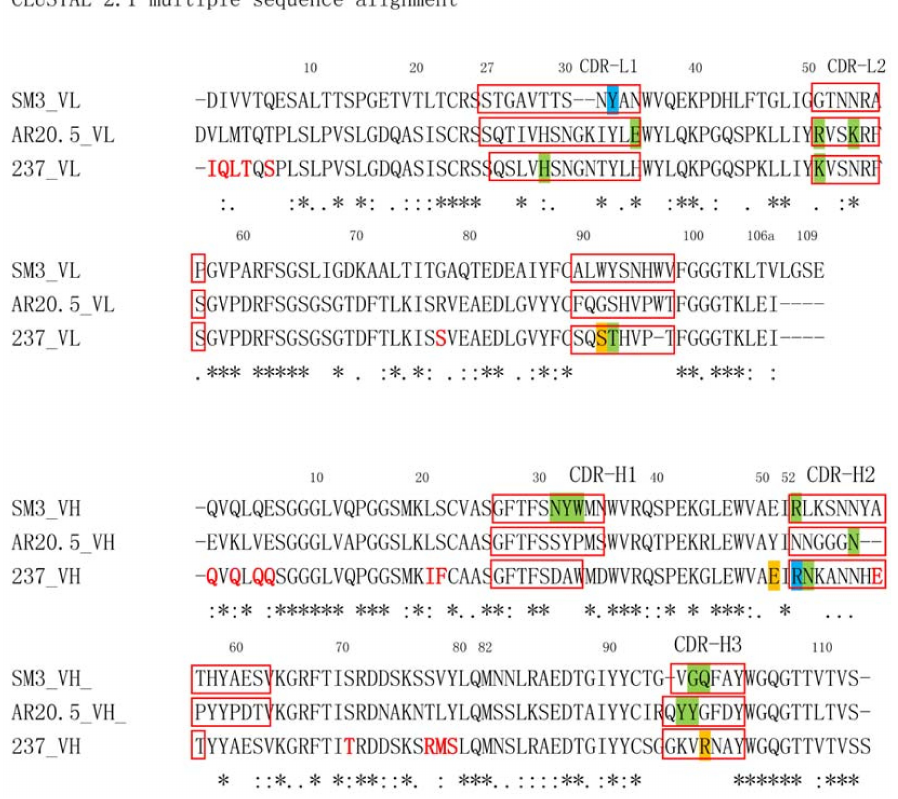
Figure 5. Sequence alignment of the scFV of anti-Muc1 antibodies and mAb237. The somatic mutations occurred at the framework region of mAb237 are highlighted as red bold letters. CDR loops of different antibodies are highlighted in red rectangles. Residues with green background interact with the peptide via hydrogen bonding and hydrophobic interactions, whereas residues highlighted in cyan background form interactions with both peptide and GalNAc. Residues only hydrogen bond with the carbohydrate moiety of the antigen are highlighted in